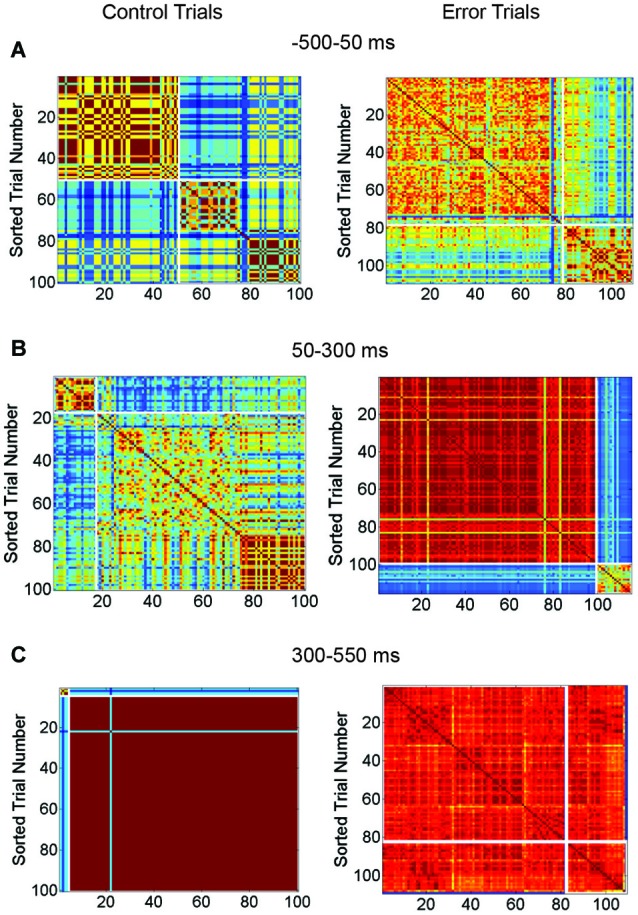
Matrix Comparing Similarity of Bursting and Non-Bursting Responses During Sequential Stimulus Trials. Matrices encode the similarity of network responses. Color of cells indicates the similarity of responses by correlation strength. Average entropy of the clusters is given at top of each figure. Other conventions as in Figure 4. (A) Clusters of similar network responses during time bin when stimuli are presented (50 ms to 300 ms) for control (left) and trials with SNBs (right). (B) Clusters of similar responses during the time bin (300 ms to 550 ms) when the SNB usually occurs on trials with SNBs (right). Data from trials without SNBs also shown (left). (C) Clusters of similar responses during the third time bin (550–800 ms) for trials without SNBs the relationship between similar network responses and stimulus identity has deteriorated in this time bin. Trials with SNBs remain unselective for stimuli. (1905-Dish4 DIV11).